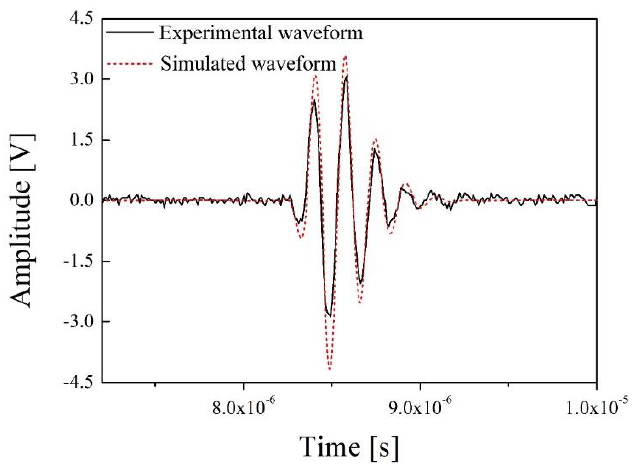
Figure 10. Through-transmitted waveforms of the defective specimen and its simulation result.